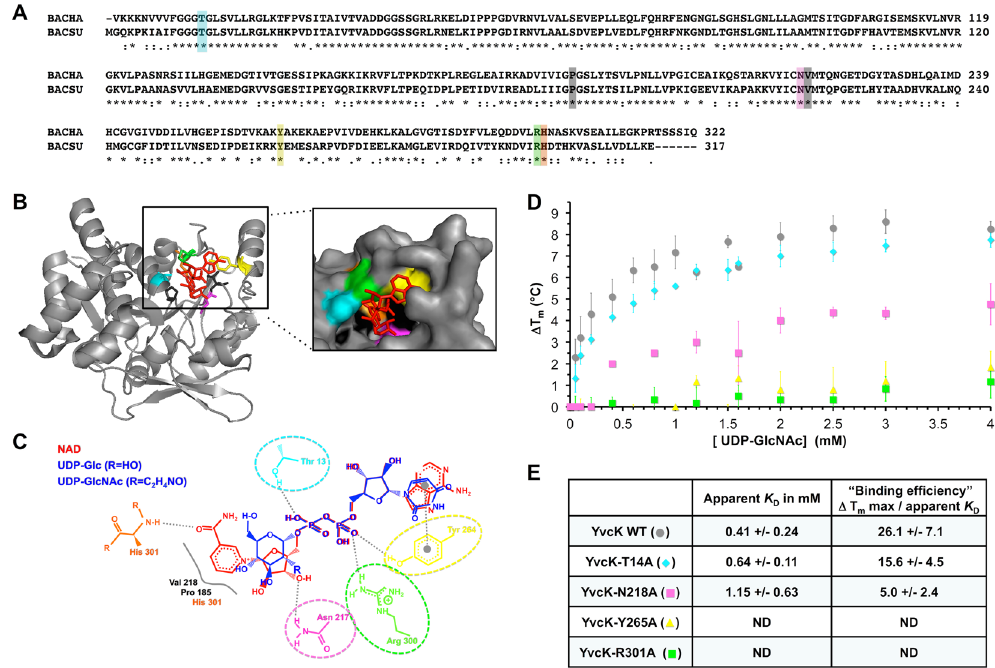
Figure 4. Identification of residues involved in UDP-sugars binding. ( A ) Sequence alignment of YvcK from B. subtilis and from B. halodurans . The highlighted amino acids are those found to interact with NAD in the crystal structure. ( B ) Crystal structure of a monomer of B. halodurans YvcK in complex with NAD (PDB ID: 2O2Z). The colored residues of YvcK were found to interact with NAD. The figure was realized with PyMOL software. ( C ) Identification of YvcK residues susceptible to interact with UDP-sugars. This scheme generated by PoseView software represents the residues of B. halodurans YvcK that interact with NAD. A molecule of UDP- Glc or UDP-GlcNAc was superposed to NAD and residues of YvcK that could interact with UDP-Glc or UDP- GlcNAc are encircled. ( D ) TSA results for the binding of UDP-GlcNAc to B. subtilis YvcK modified proteins. Four YvcK residues found to interact with NAD in the crystal structure were replaced by Ala to generate YvcK- T14A, YvcK-N218A, YvcK-Y265A and YvcK-R301A. The proteins were purified and TSA was performed in the presence of increasing concentrations of UDP-GlcNAc (0 to 4 mM). The difference of temperature was plotted against the concentration of UDP-GlcNAc for YvcK (grey circle) and each modified protein: YvcK-T14A (cyan diamond), YvcK-N218A (pink square), YvcK-Y265A (yellow triangle) and YvcK-R301A (green square). All the values correspond to the average of data from at least 3 independent experiments and the standard deviations are representated by the error bars. ( E ) Kinetic parameters for the binding of UDP-GlcNAc to B. subtilis YvcK modified proteins from TSA experiments. The apparent K D , the Δ T m max and the standard deviations were calculated using Microcal Origin 5.0 software. ND indicates that the binding of UDP-GlcNAc to YvcK and the Δ